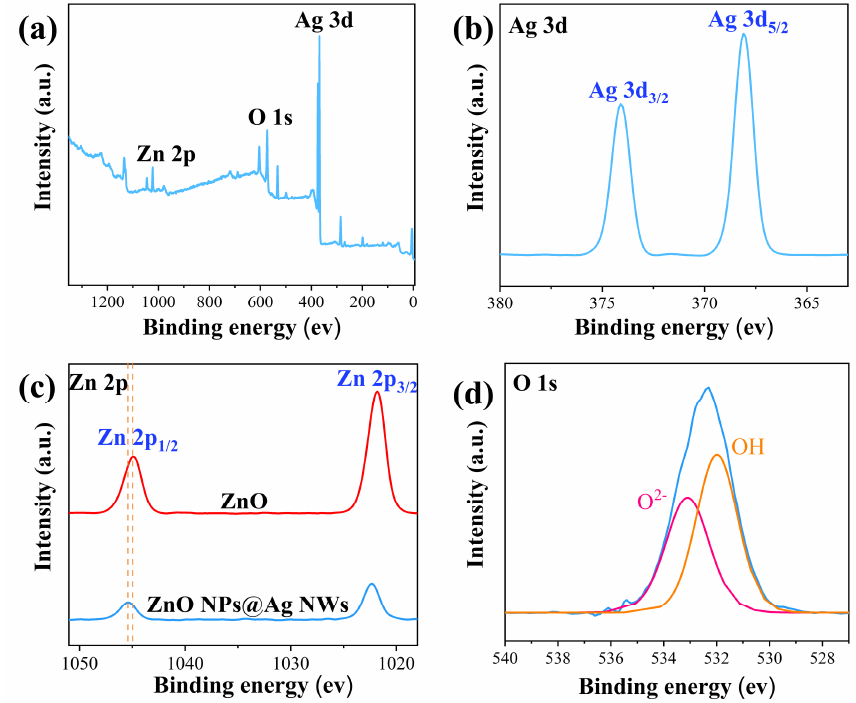
Figure 3. ( a ) XPS of ZnO NPs@Ag NWs. ( b – d ) High-resolution XPS spectra of Ag 3d, Zn 2p, and O